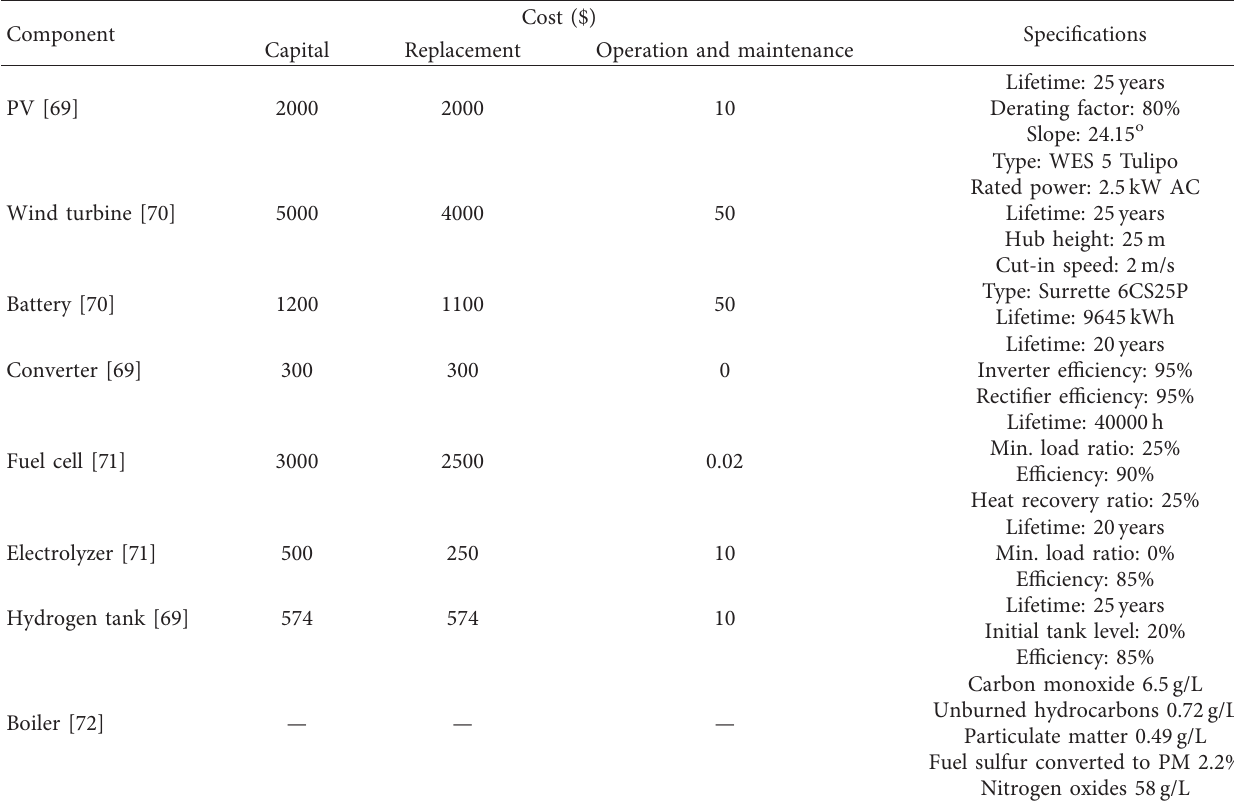
Table 2: Specifications and price of equipment.